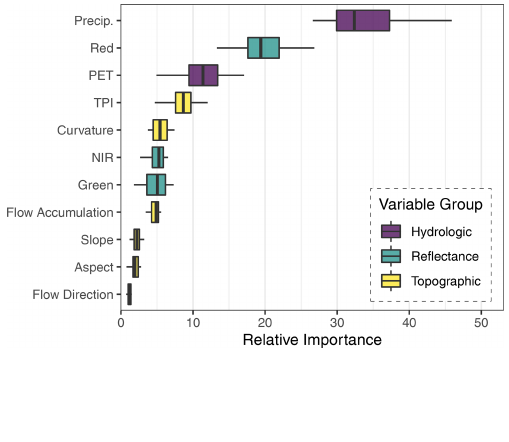
Figure 8. Relative variable importance distribution of the 30 BRT models aggregated by variable